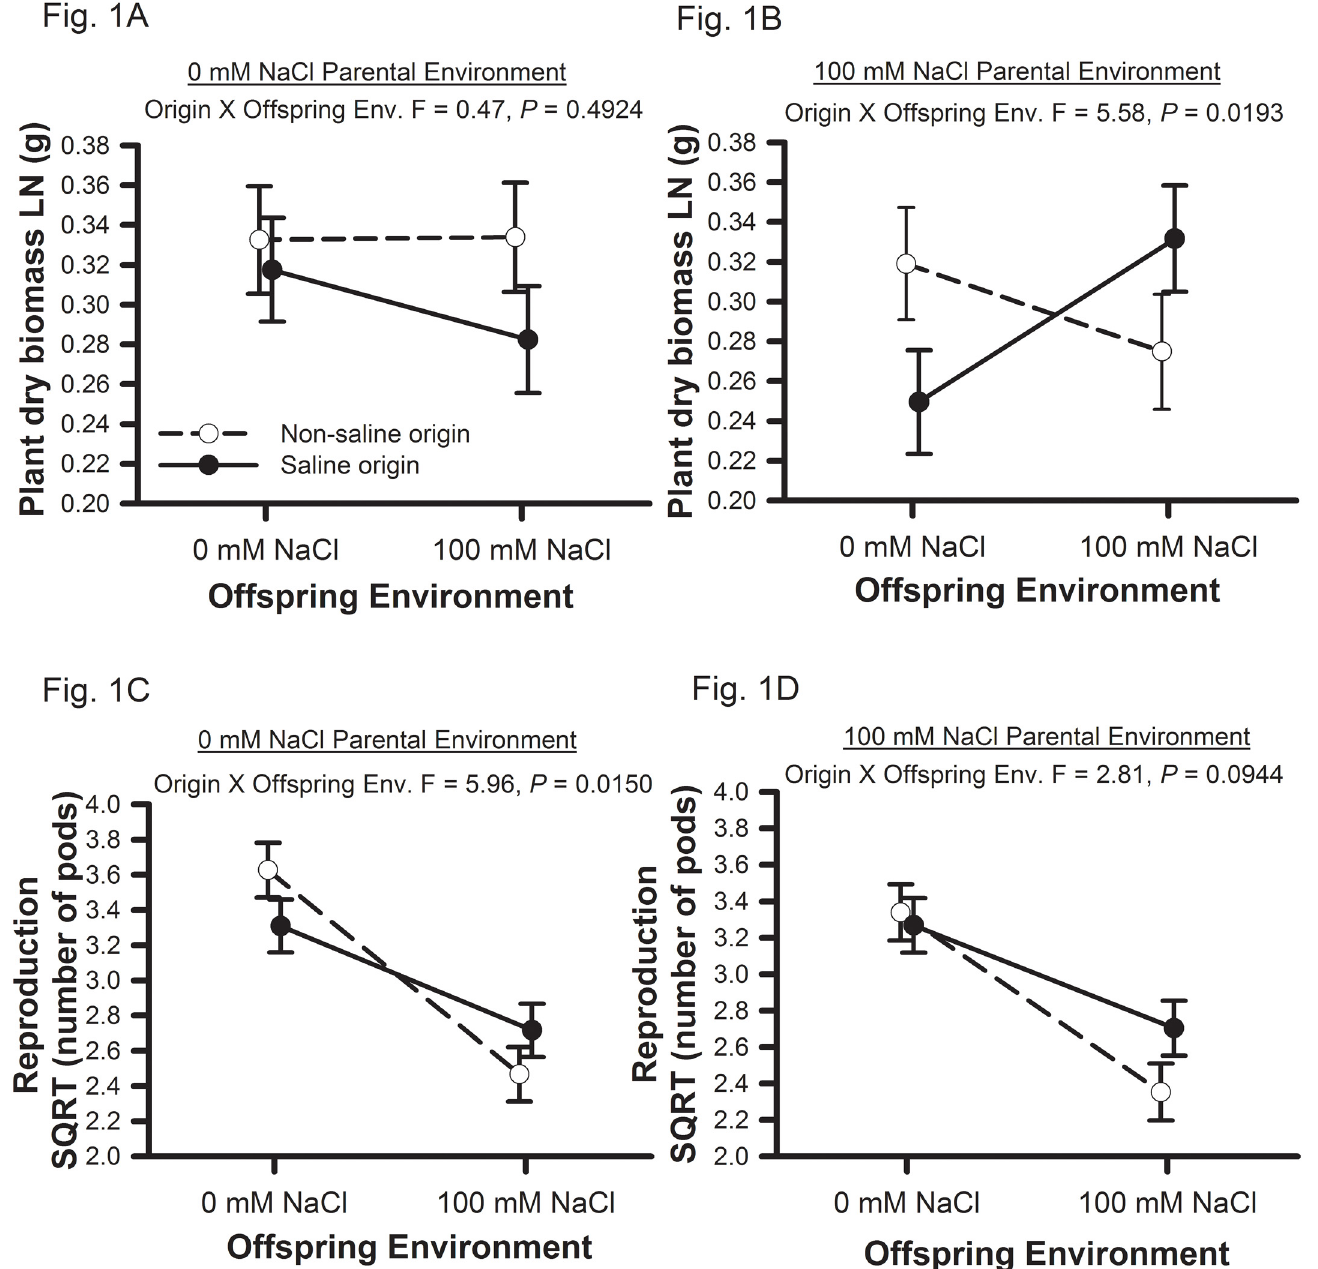
Fig 1. Origin of population performance responses to parental and offspring soil salinity treatments. Origin of population means and one standard error for total dry vegetative biomass (A, B) and reproduction (C, D). Figs A and C show results when parental plants were grown in 0mM NaCl, and Figs B and D show results when parental plants were grown in 100mM NaCl. Non-saline origins are shown with open circles and saline origins are shown with closed circles. ANOVA statistics for origin by offspring environment calculated for each parental environment are shown.